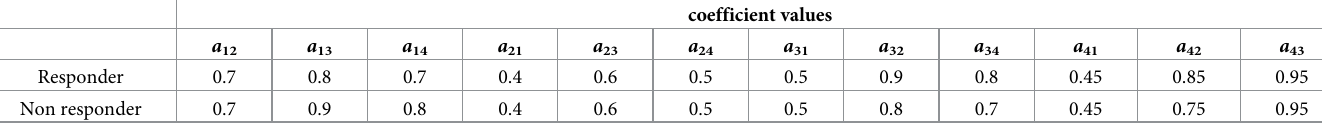
Table 2. The coefficients of payoff matrix A (doi:10.1158/1078-0432.ccr-19-0006).